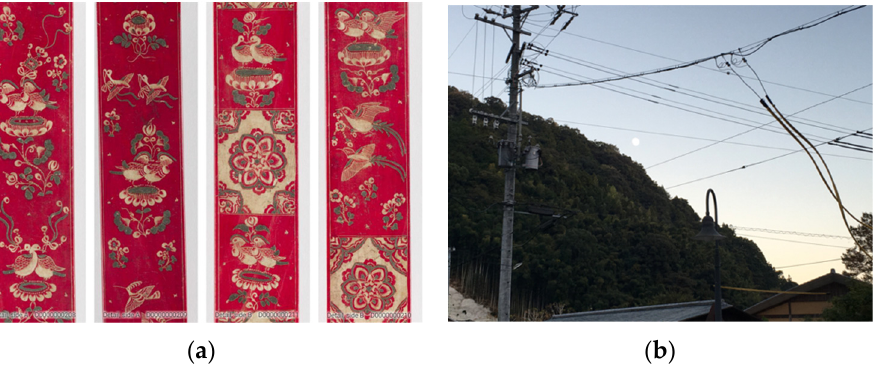
Figure 4. ( a ) Author unknown, Sh ō s ō in Treasure: red-stained ivory shaku ruler with bachiru decoration, ( 乙 ) (cropped images ) , detail: side A D0000000208, side A D0000000209, side B D0000000211, side B D0000000210, ivory dyed in red ( Bachiru ), 29.8 × 2.6 × 0.7 cm, Imperial Household Agency, Sh ō s ō in, Nara, Japan; ( b ) The Mountain breathes out the moons.